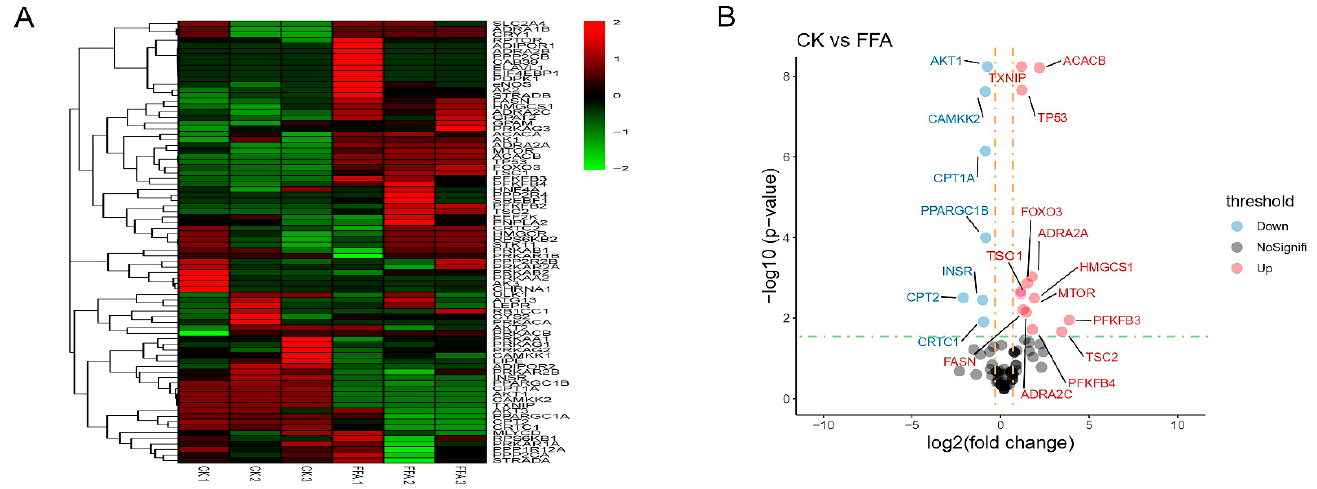
Figure 5. Effect of FFA treatment for 24 h on the expression of genes related to the AMPK signaling pathway in primary hepatocytes of laying hens. ( A ) Heatmap. The color indicates the gene expression level of log10 transformation (red indicates high expression level, green indicates low expression level). ( B ) Volcano plot. Gray dots indicate genes with no significant expression differences between groups under the dashed line, and colored dots above the dashed line indicate genes with significant expression differences between groups. Red indicates increased expression, while blue indicates decreased expression. Data are shown as the mean ± SD (n = 6).